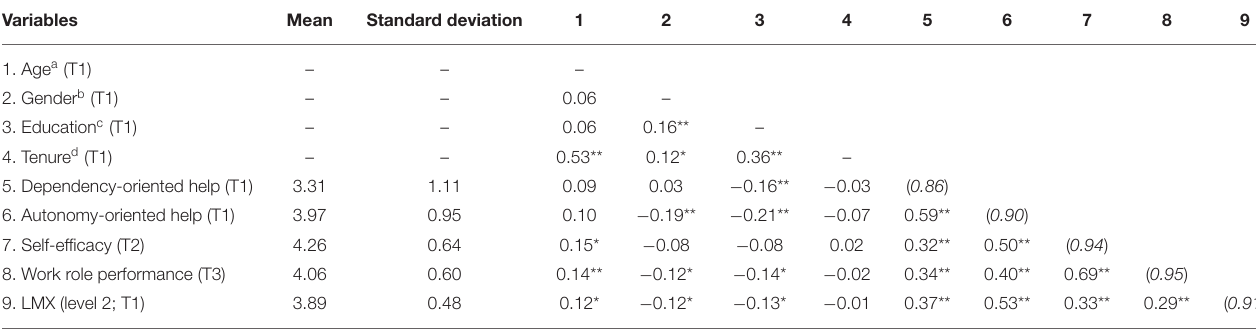
TABLE 1 | Means, standard deviations, correlations, and reliability. Variables